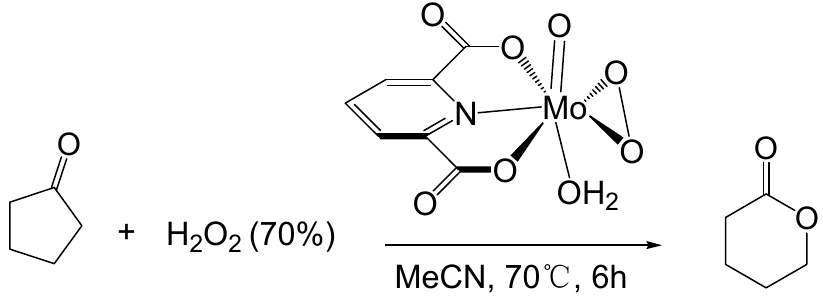
Figure 6. Oxidation of cyclic ketones catalyzed by molybdenum peroxy complex [58].